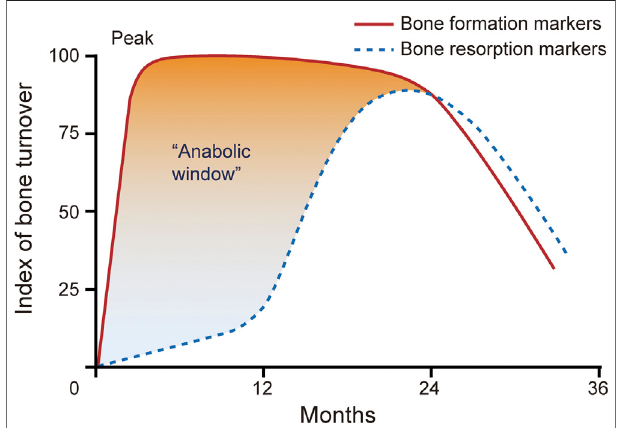
FIGURE 1 | The anabolic window. The fi gure shows the concept that bone formation is fi rst stimulated by PTH followed by a later increase in bone resorption [adapted from (Pazianas,